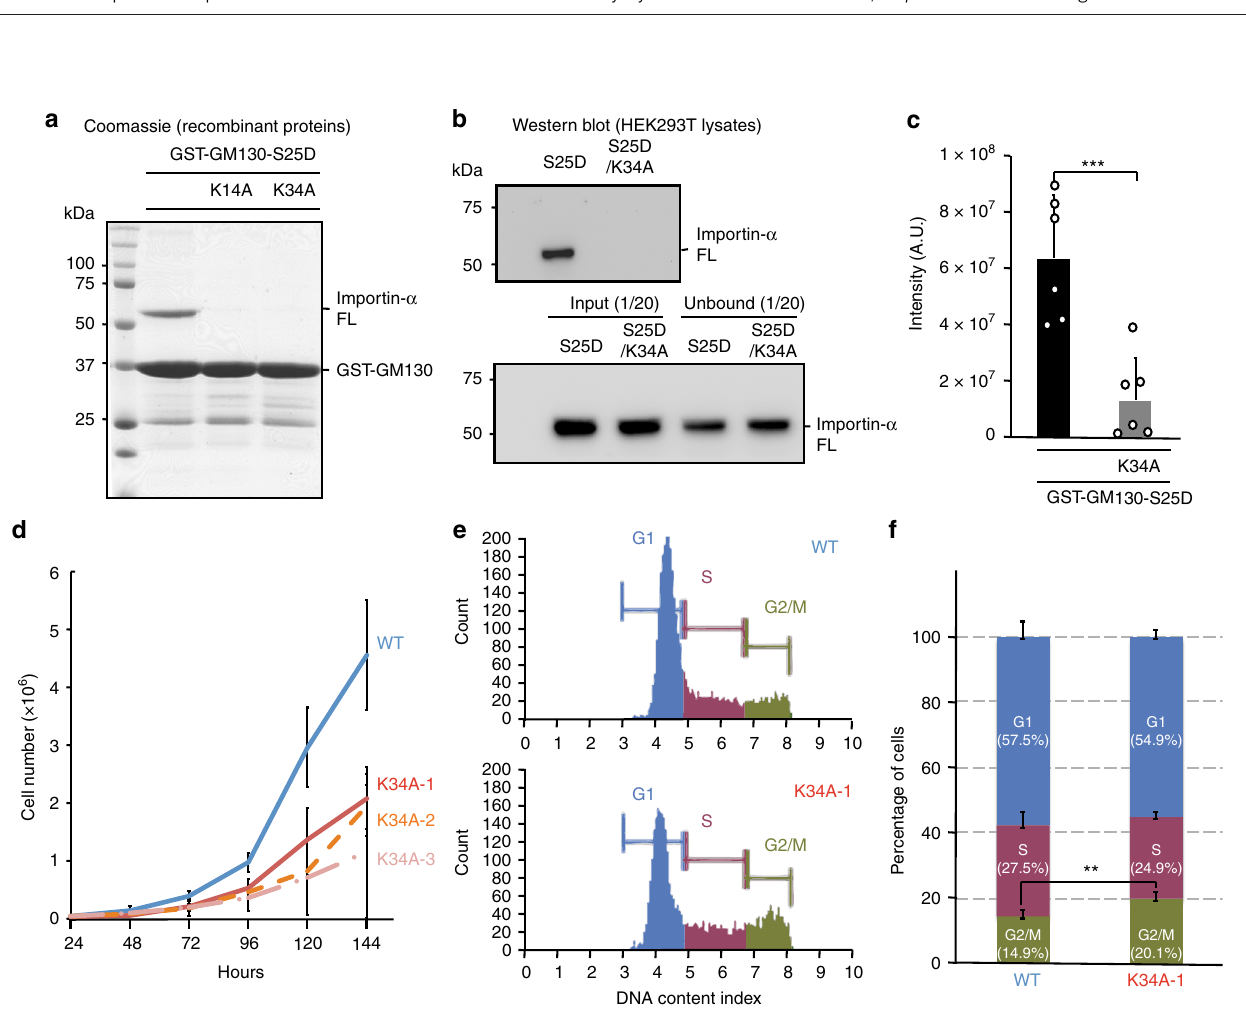
Fig. 4 Ran and a phosphate moiety repress GM130 and Importin- β interaction. a SEC (Superdex 200) elution pro fi les for the Importin- β (cid:129) GST-GM130-WT complex (black line), Importin- β (gray line), and GST-GM130-WT (light gray line). The void volume ( Vo ) is indicated. b – d The peak fractions of the Importin- β (cid:129) GST-GM130-WT complex ( b ), Importin- β ( c ), and GST-GM130-WT ( d ) were analyzed by SDS – PAGE and stained with Coomassie blue. e , f ITC titration curves (upper) and binding isotherms (lower) of Importin- β with GM130-NLS WT ( e ) and GM130-NLS phospho-S25 ( f ). K d values are indicated. g Competition binding assay. GST-GM130-S25D and Importin- β were incubated with indicated concentrations of GFP-IBB. Samples pulled down by GST beads were analyzed by SDS – PAGE and stained with Coomassie blue. The asterisk indicates the contamination of GFP-IBB in the pulldown. h GST pulldown assays of GM130-WT or GM130-S25D with Importin- β in the presence or absence of RanQ69L. i Analysis of the dissociation of Importin- β from either GM130-WT or GM130-S25D in the presence of RanQ69L. j GST pulldown assays of GM130-S25D with Importin- α FL or Importin- β in the presence or absence of RanQ69L. k Analysis of the dissociation of Importin- α FL and Importin- β from GM130-S25D in the presence of RanQ69L. For both GST pulldown assays, GST-fused GM130 (WT and S25D) was incubated with His-tagged RanQ69L and recombinant Importin- α FL or Importin- β at a molar ratio of 1:4:1 GM130:RanQ69L:Importin. GST-bound samples were analyzed by SDS – PAGE and stained with Coomassie blue. i , k Band intensities of Importin- α or Importin- β from the SDS – PAGE gels in h , j were used to determine averages of bound protein. Data represent mean ± standard deviation from three independent experiments. Differences were assessed statistically by two-tailed Student ’ s t- test; *** p < 0.005. n.s. not signi fi cant